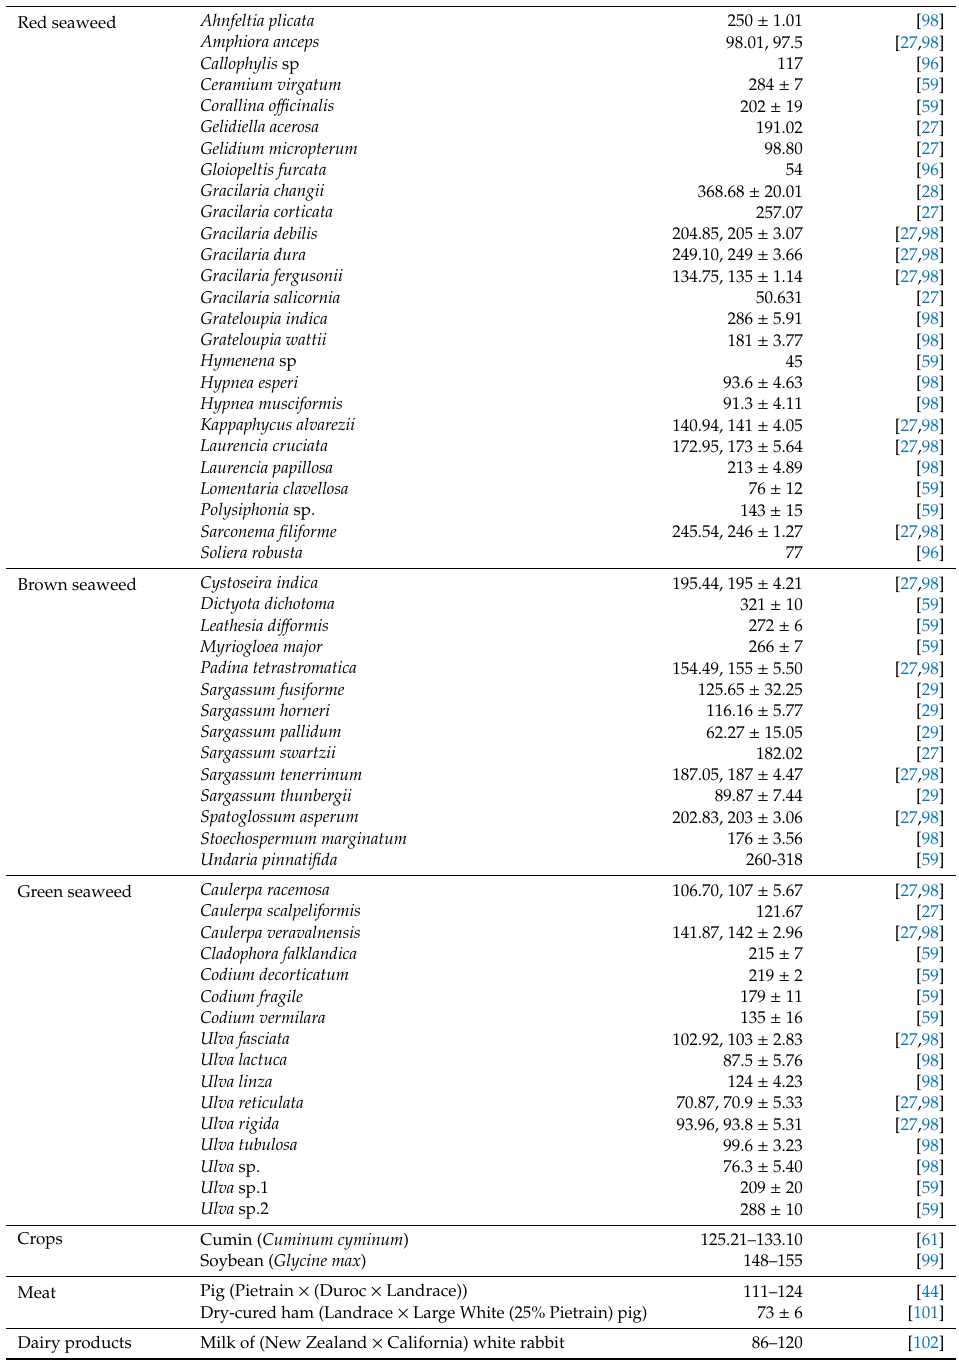
Table 7. Application of UI in fatty acid evaluation